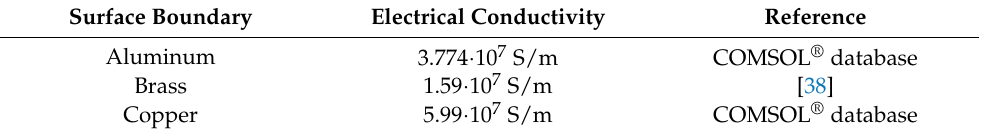
Table 3. Electrical conductivities of metallic materials inside the waveguide.